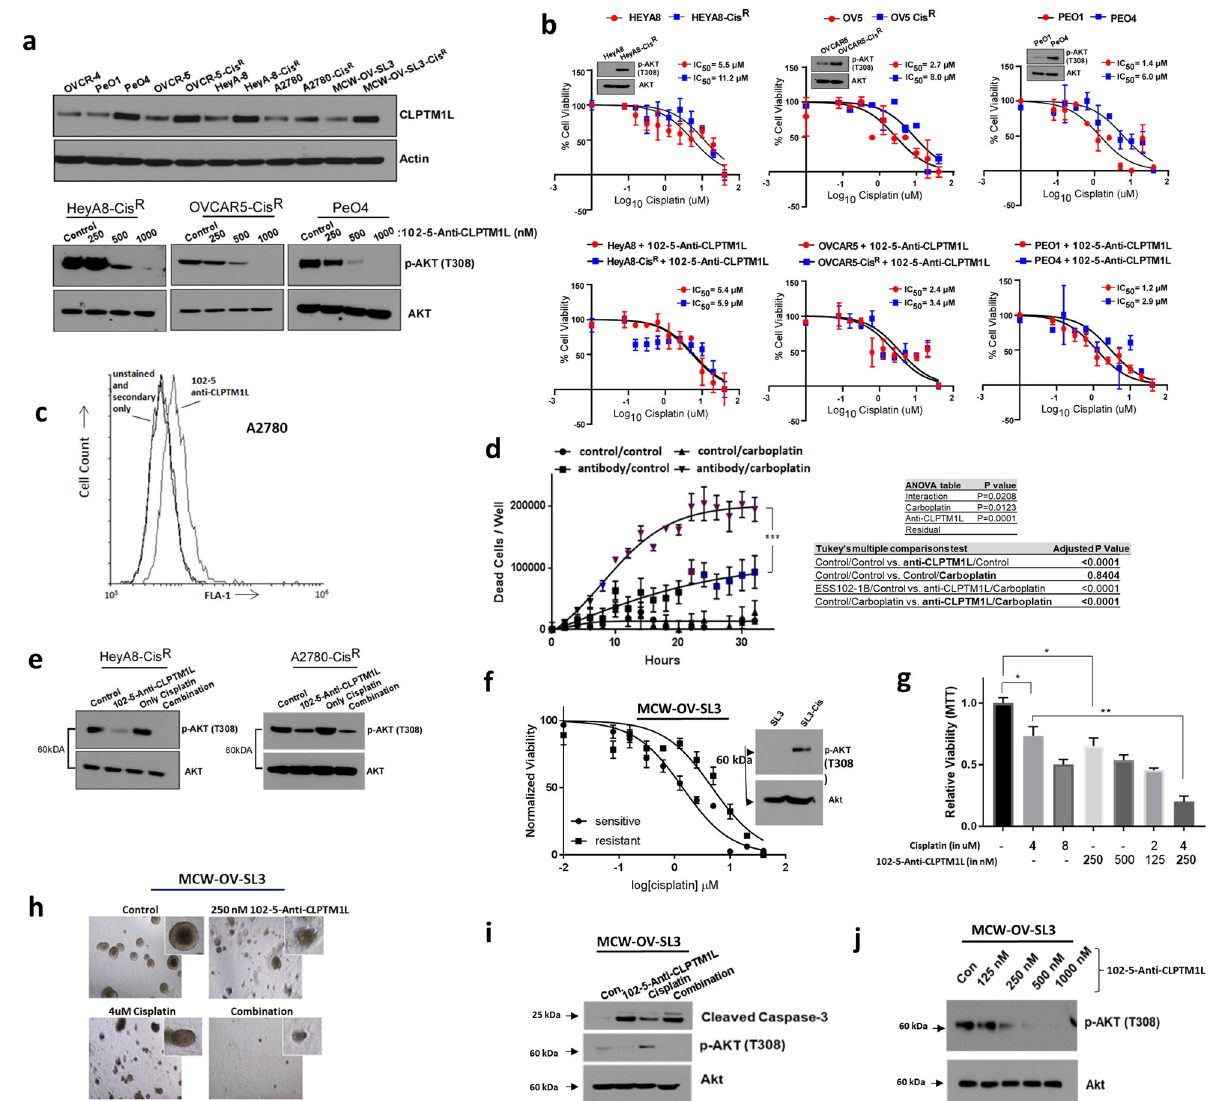
Fig. 2 Resensitization to chemotherapeutic killing by 102-5 anti-CLPTM1L. a Western blotting of cisplatin-sensitive and resistant ovarian tumor cell lysates for CLPTM1L and analysis of dose – response of phospho-Akt and total Akt to 102-5 anti-CLPTM1L treatment. b Dose – response analyses and cisplatin IC50s of cisplatin-sensitive and resistant human ovarian tumor cells. Error bars represent standard error of the mean. Akt phosphorylation levels in resistant versus resistant lines are shown in insets. c Flow cytometry on A2780 detecting cell surface CLPTM1L with 102-5 human anti-CLPTM1L. d Kinetic killing assay (live imaging) in A2780 with human anti-CLPTM1L and/or 10 µM carboplatin treatment. Error bars represent standard error of the mean. * p < 0.05, ** p < 0.005, *** p < 0.0005. e Western blotting for Akt and phospho-Akt (T308) in A2780 and HeyA8 resistant cell lines treated with 102-5 anti-CLPTM1L and/or cisplatin. f Cisplatin dose – response curves for MCW-OV-SL3 sensitive (parental) and resistant (MCW-OV-SL3-Cis R ) tumor spheroids, pAkt (T308) and total Akt western blots on MCW-OV-SL3 and MCW-OV-SL3-Cis R spheroid lysates (inset). Error bars represent standard error of the mean. g Viability (MTT) of MCW-OV- SL3-Cis R spheroids after 16 days of growth, treated with cisplatin and/or 102-5 anti-CLPTM1L at the indicated concentrations beginning